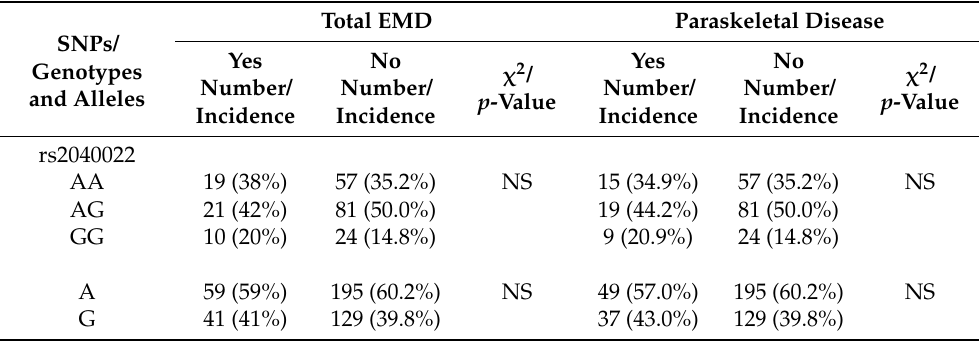
Table 4. Genotype and allele frequencies of the HPSE2 gene SNPs in correlation with primary extramedullary disease (EMD) in multiple